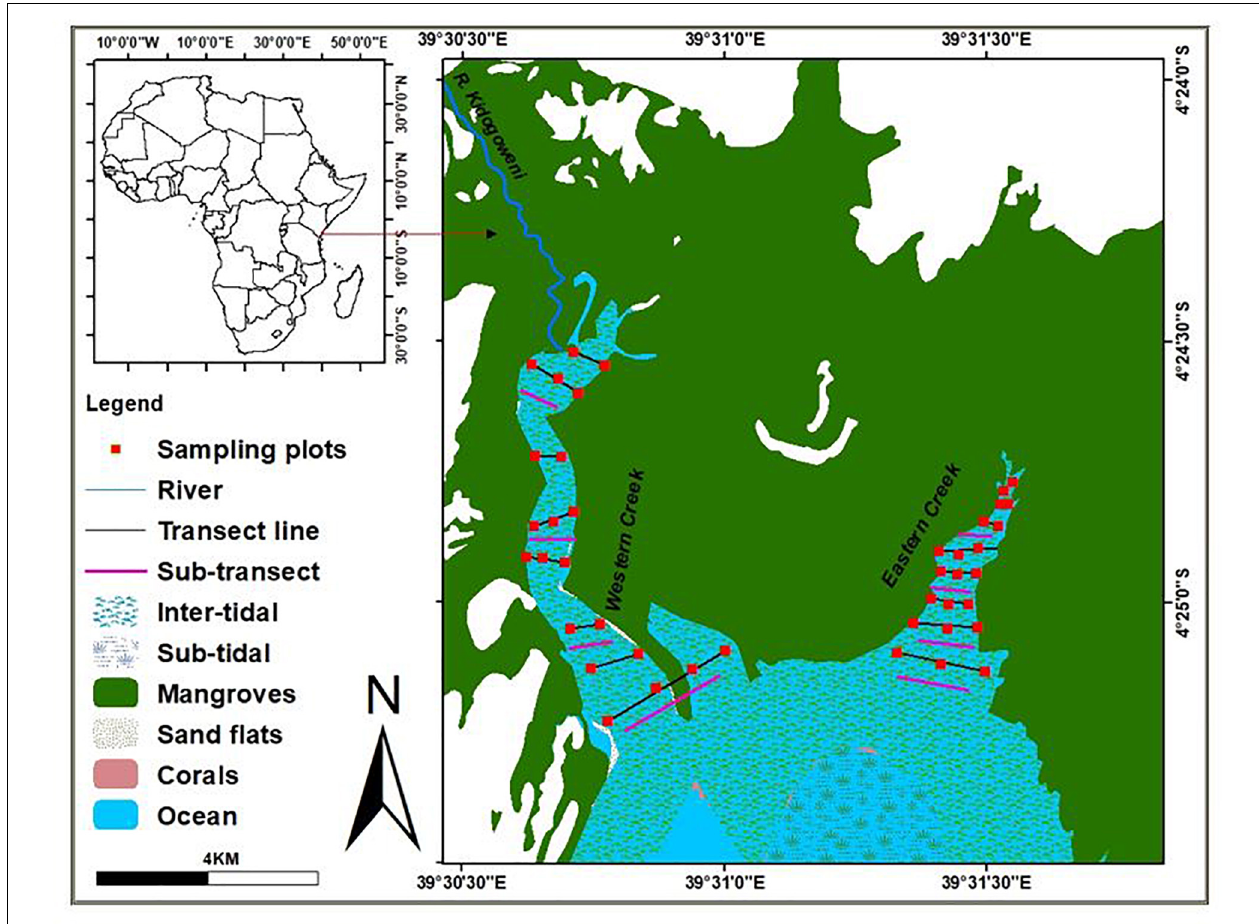
FIGURE 1 | MAP of Gazi Bay indicating the creeks and seagrass-covered areas.